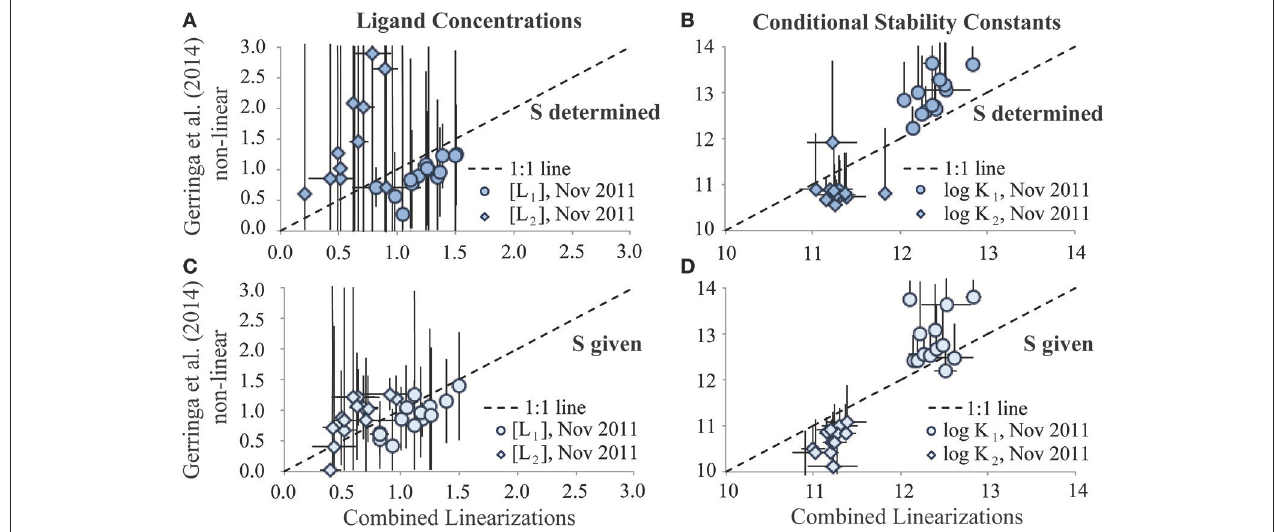
FIGURE 4 | Results of the two ligand class reinterpretation exercises of the GA03 (Nov 2011) dataset for ligand concentrations ( A,C ; units: nM Eq Fe) and log conditional stability constants ( B,D ; units of K: M − 1 ). Results from the Combined Linearization approach to data interpretation are plotted on the x-axes vs. the results from the Gerringa et al. (2014) non-linear data interpretation approach on the y-axes. Stronger DFe-binding ligand results are represented by circles and weaker DFe-binding ligand results are represented by diamonds. Upper panels depict results from when the sensitivity parameter (S) was determined in the reinterpretation exercise. Lower panels depict results of the reinterpretation exercise from when the S parameter was given by the original